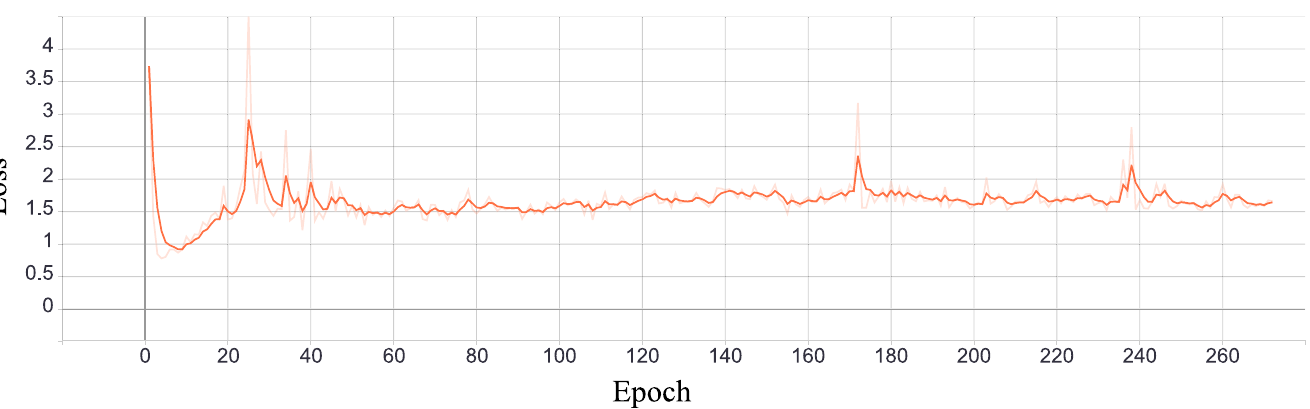
Fig 7. Discriminators total loss (sum of categorical discriminator’s and normal discriminator’s loss values during training).